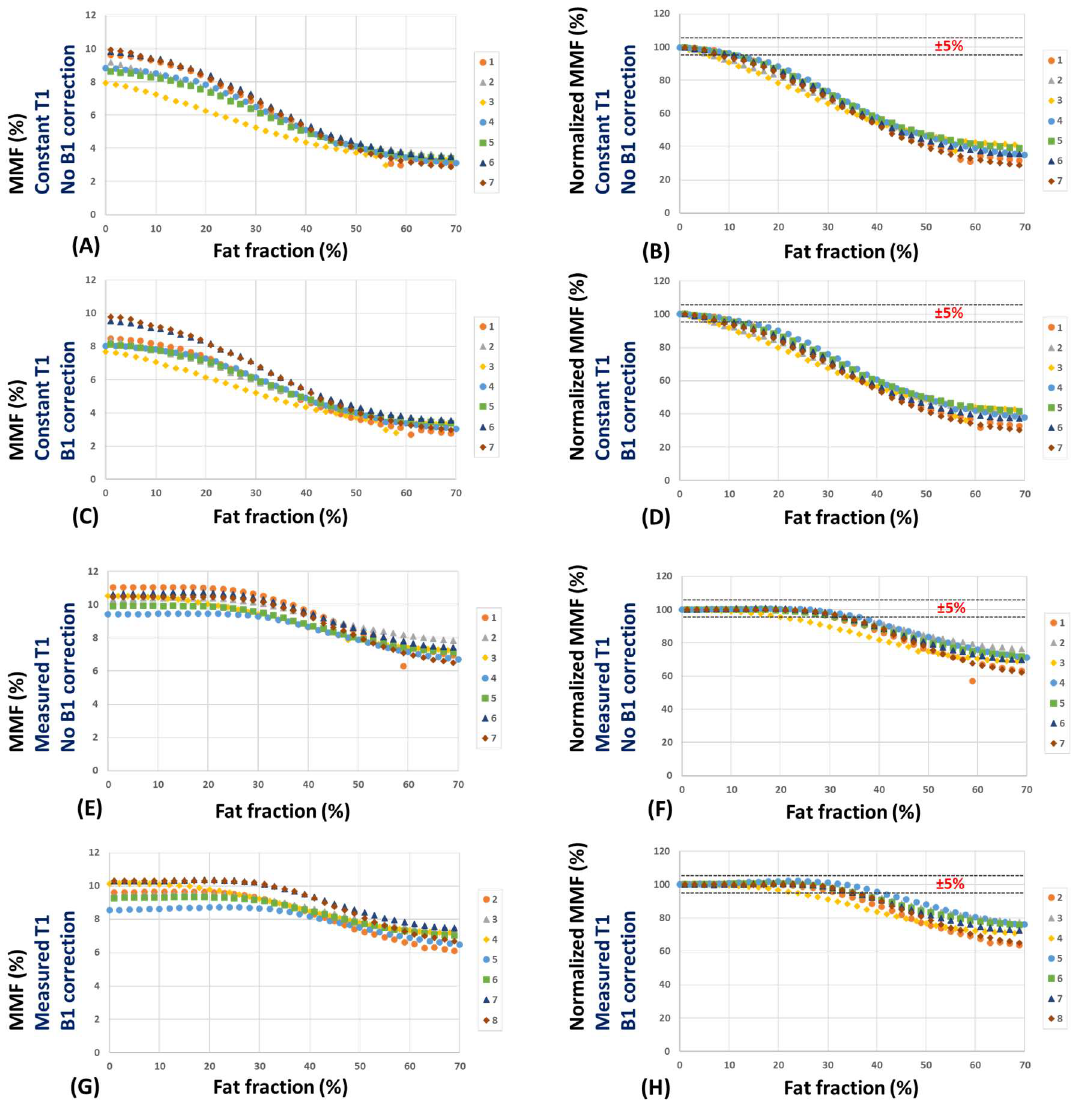
Figure 5. MMF and normalized MMF values versus FF within the seven expanding ROIs (FF = 0 to 70%) using ( A , B ) a constant T1 (T1 = 750 ms) and no B1 correction, ( C , D ) a constant T1 and B1 correction, ( E , F ) a measured T1 (from the AFI-VFA sequence) and no B1 correction, and ( G , H ) a measured T1 and B1 correction. MMF decreased by more than 5% for FF above 10% when constant T1 (T1 = 750 ms) was used ( A – D ). However, when an accurately measured T1 was used ( E – H ), the 5% MMF reduction occurred for FF > 30%. The calculated MMF using a measured T1 showed a less than 3% error for FF < 20%.